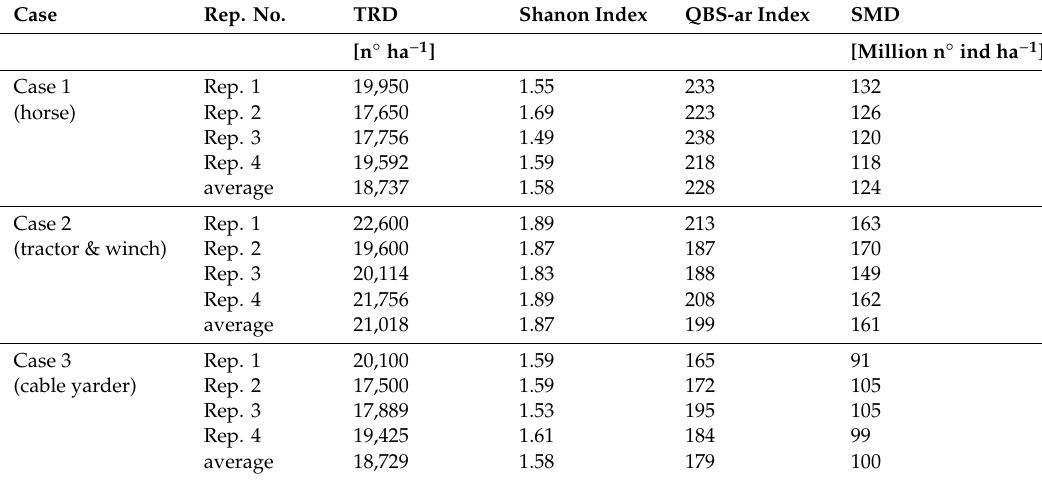
Table 7. Resulting indicator values of tree regeneration density (TRD), floristic diversity (Shannon index), Soil Biological Quality (QBS-ar index) and soil microarthropod community density (SMD), per ha.